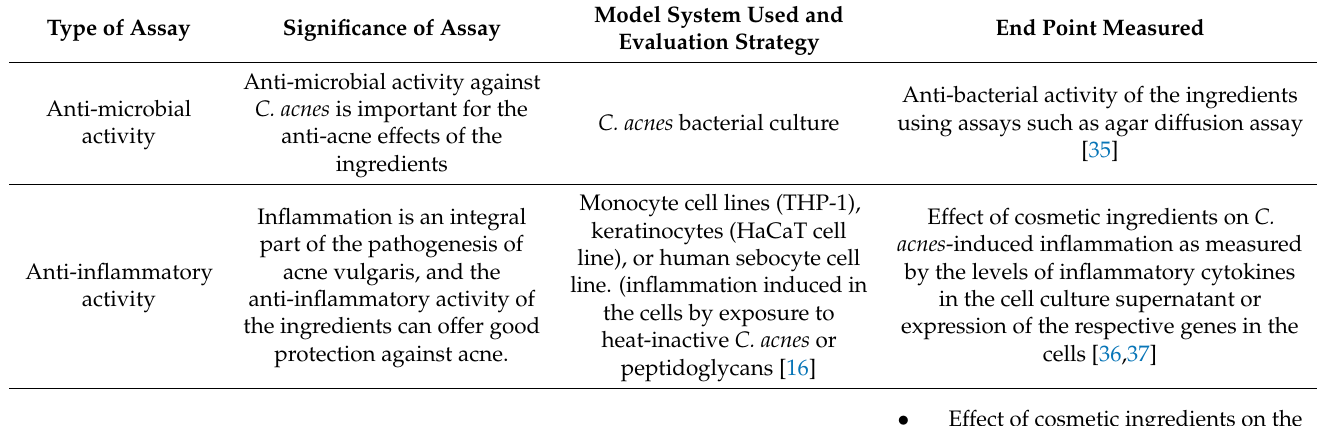
Table 1. Strategies for validation of anti-acne